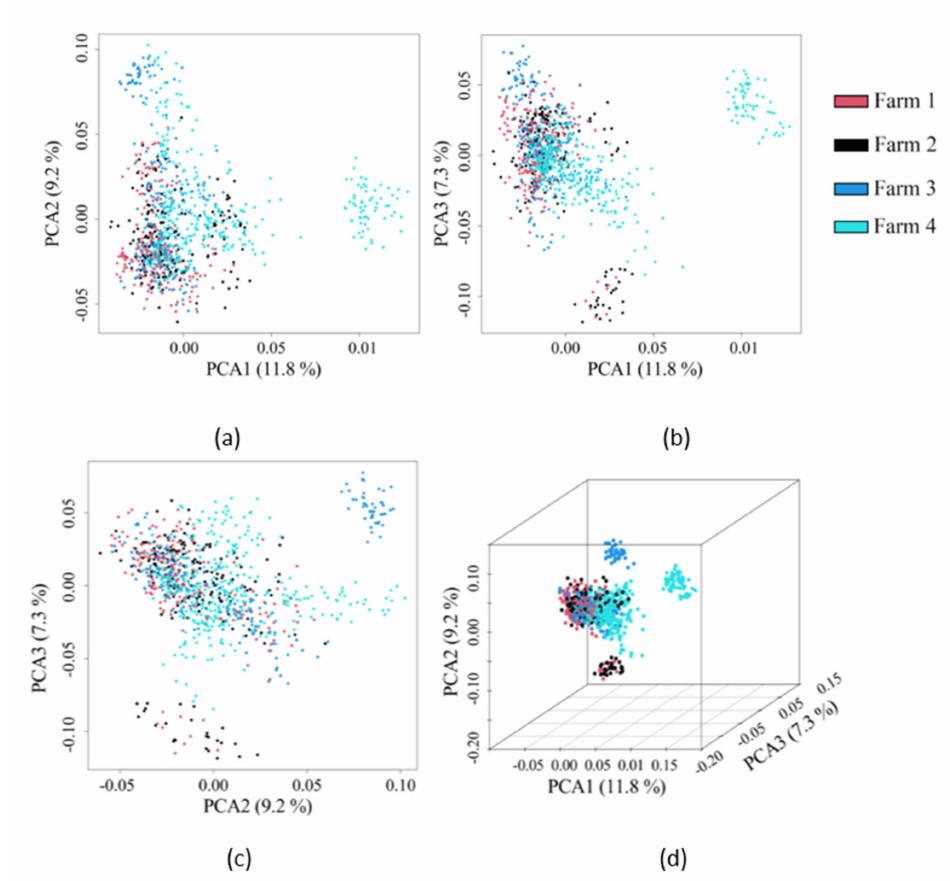
Figure 4. Population structure plots demonstrated by the 84,407 SNPs of 984 cows. The three highest principal components (PCs) were used to display the population structure by pairwise scatter plots ( a – c ) and the 3D plot ( d ). The PC1, PC2, and PC3 explained 11.8%, 9.2%, and 7.3% of the variation, respectively.